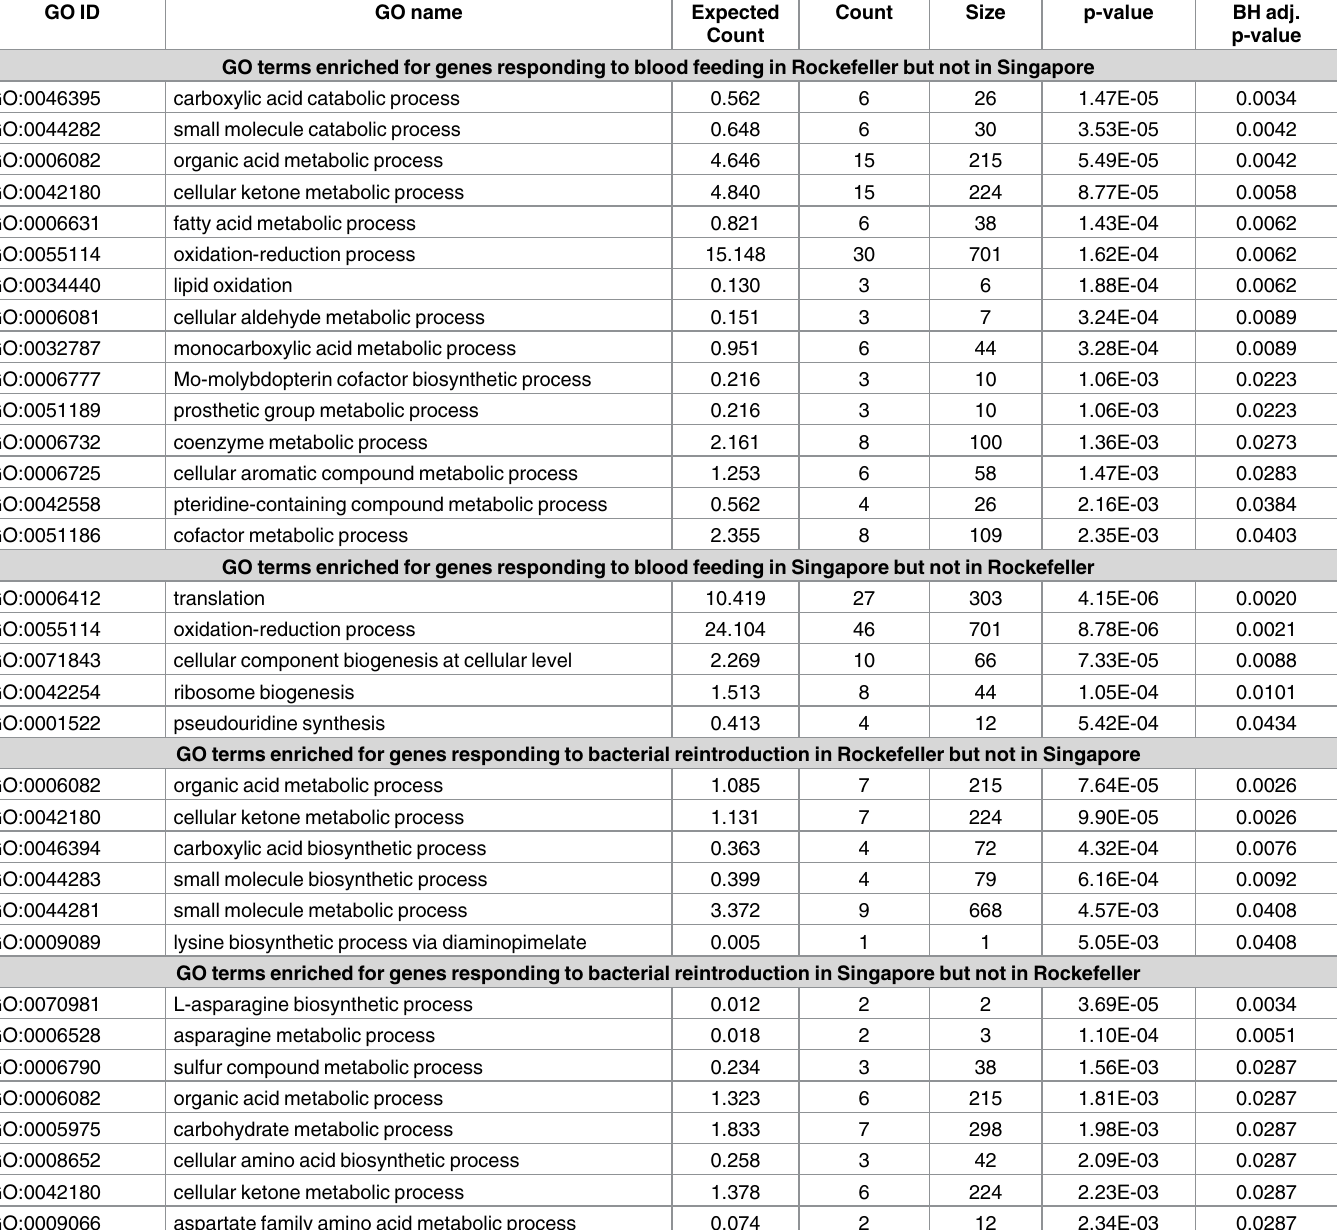
Table 2. Biological process gene ontology terms enriched for genes showing transcript abundance changes in either Rockefeller or Singapore in response to blood feeding or bacterial reintroduction. GO ID GO